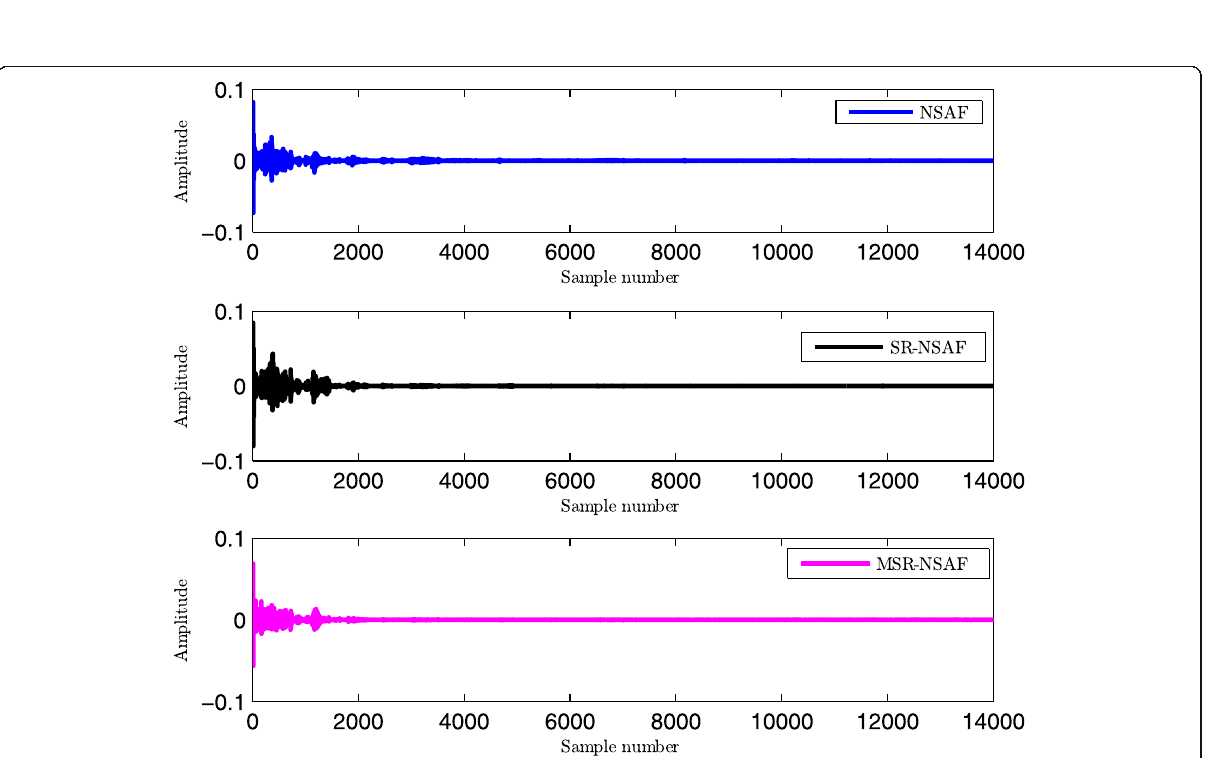
Fig. 15 Error signals with NSAF, SR-NSAF, and MSR-NSAF algorithms